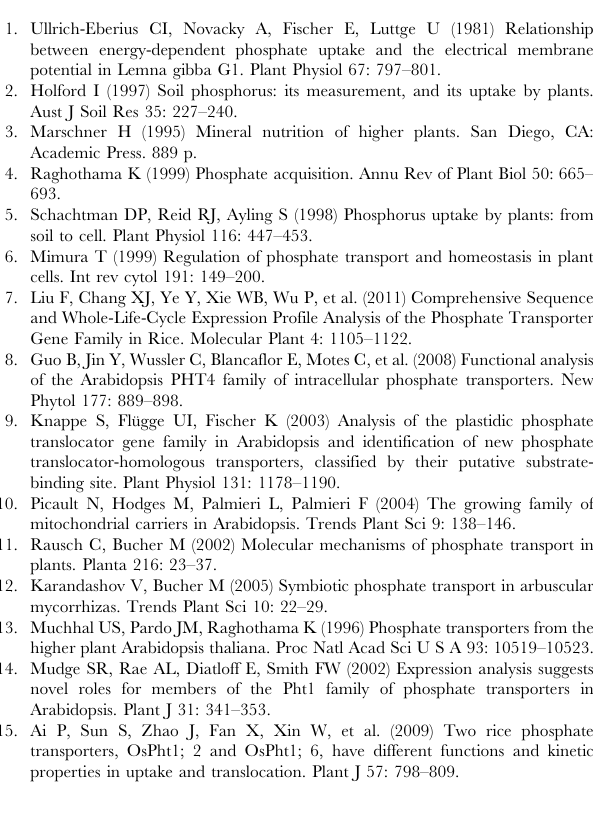
Table S3 Expression pattern of soybean GmPTs in the common used tissues in reference 37, 38. The numbers presented in the table are normalized Illumina-Solexa reads number coming from the according experiment. Table S4 Primers used to generate the expression vectors in yeast complementary assays (restriction site sequences are underlined). Table S5 Primers used to generate DNA sequences of GmPTs. Text S1 Protein sequences of